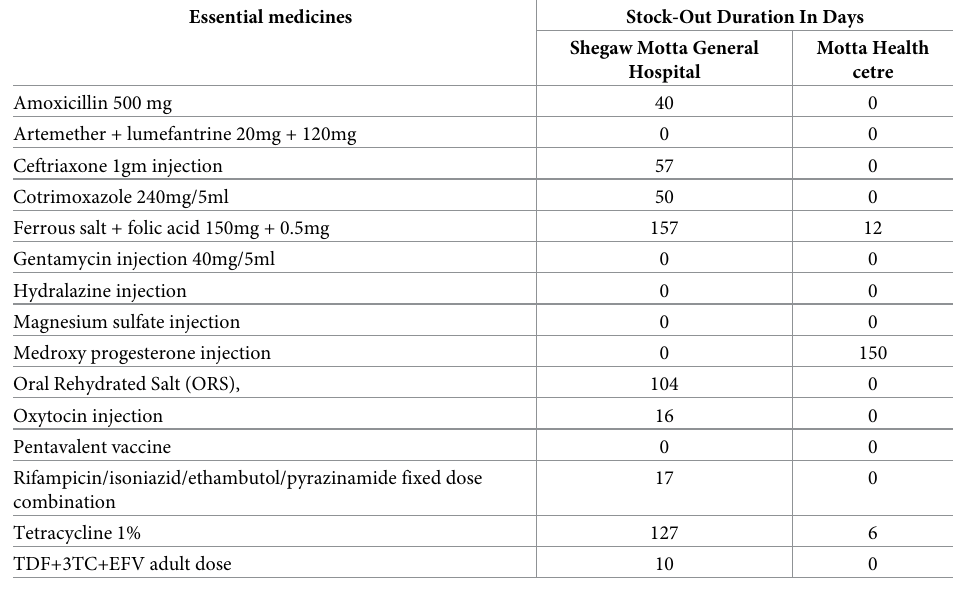
Table 4. Stock-out duration of essential medicines in the last 6-months in Shegaw Motta general hospital and Motta health